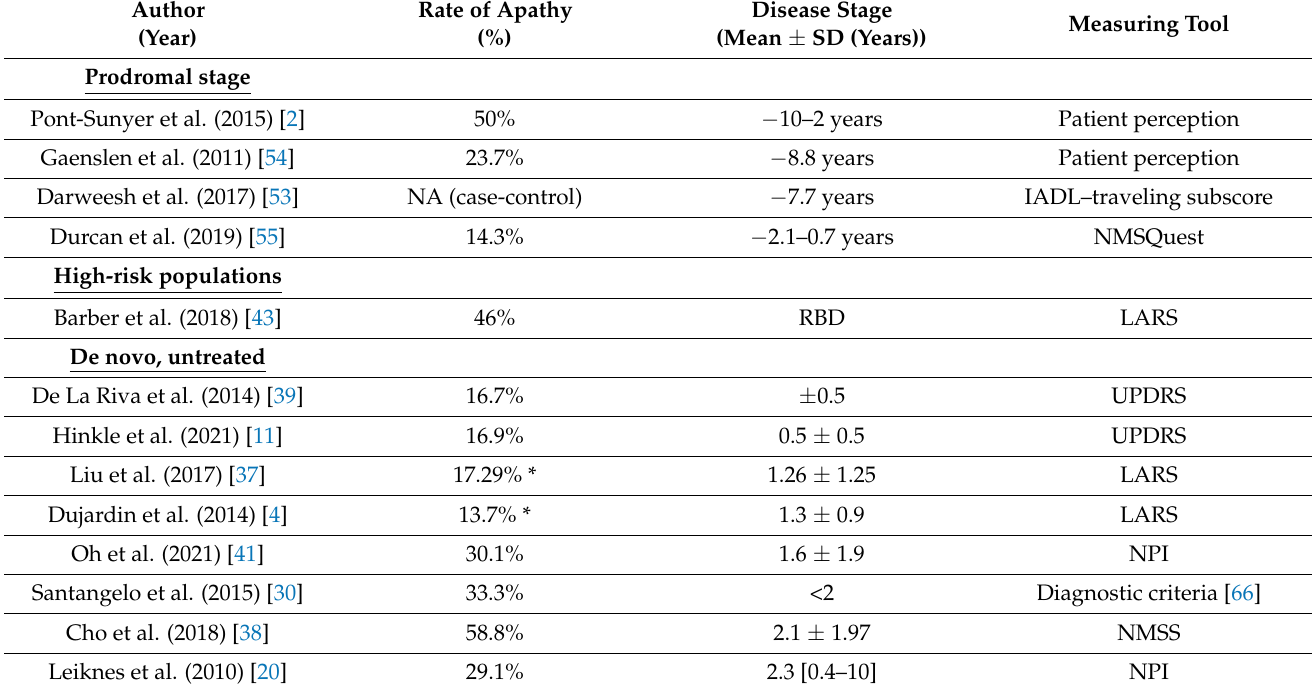
Table 1. Prevalence rates of apathy during the disease course. * Marks studies in which underlying depression was